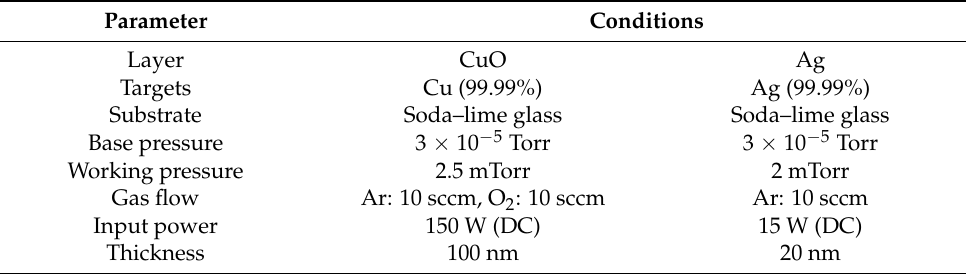
Table 1. Sputtering conditions for Ag electrode and CuO